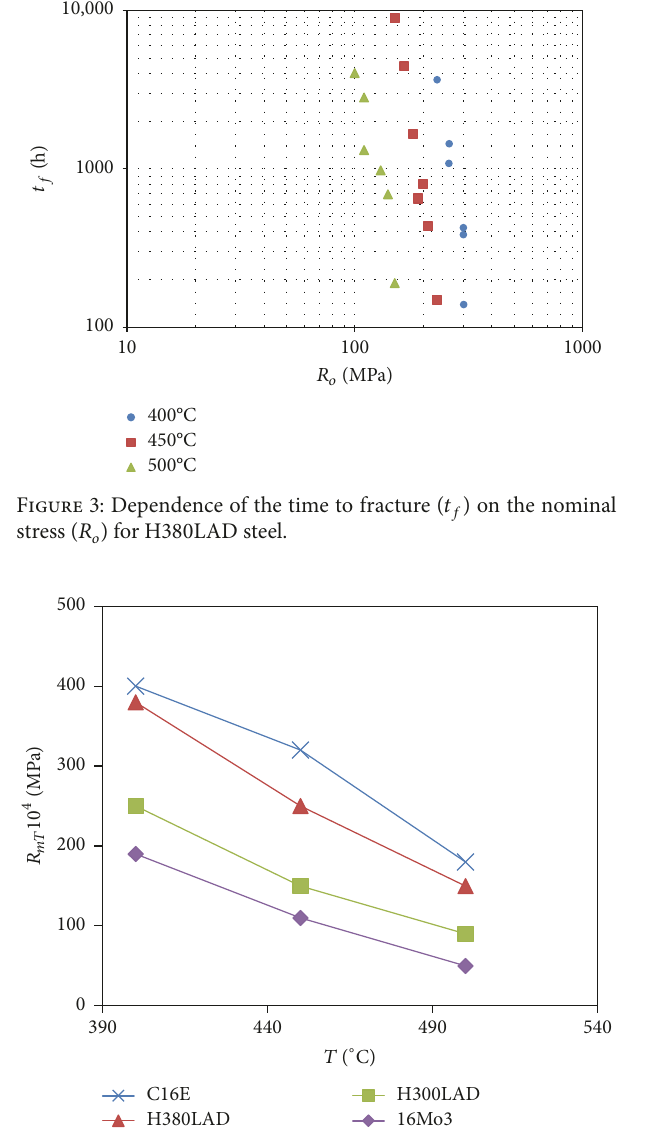
Figure 4: 𝑅 𝑚𝑇 10 4 temperature functions of tested steels and of selected creep-resistant steels.